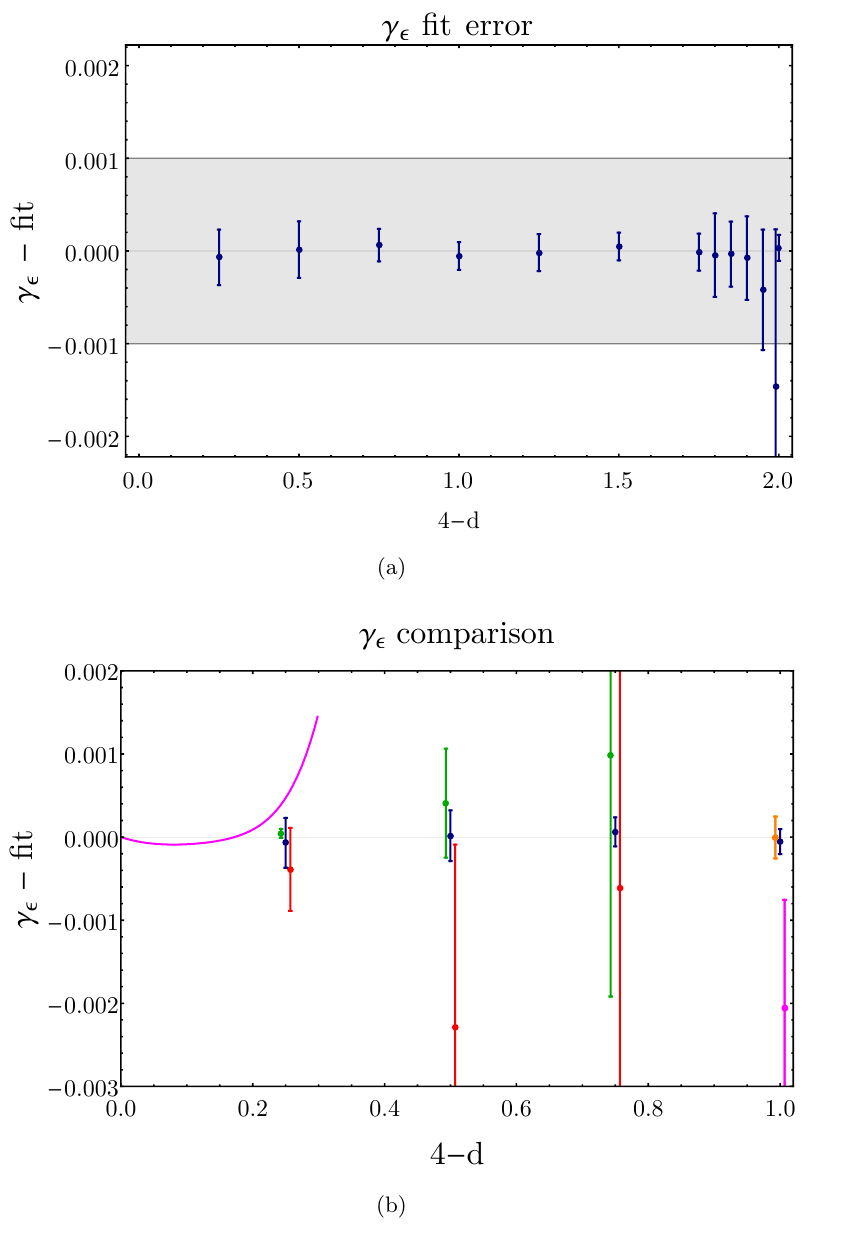
Figure 6 . (a) Polynomial (cid:12)t of (cid:13) (cid:15) bootstrap data with overall error. (b) Comparison of bootstrap data (blue) with: resummed epsilon expansion (green); 3-correlator bootstrap (red); high-order epsilon expansion and resummed estimate at d = 3 (magenta); Monte Carlo (orange) (references as in (cid:12)gure 5).